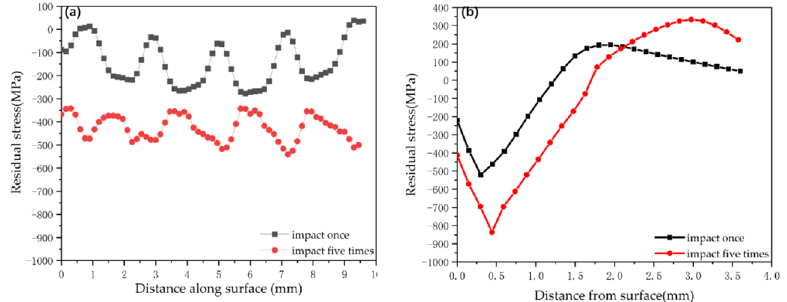
Figure 14. Residual stress of 20CrMnTi of multiple-point laser shock. ( a ) Surface residual stress distribution; ( b ) Depth direction residual stress distribution.